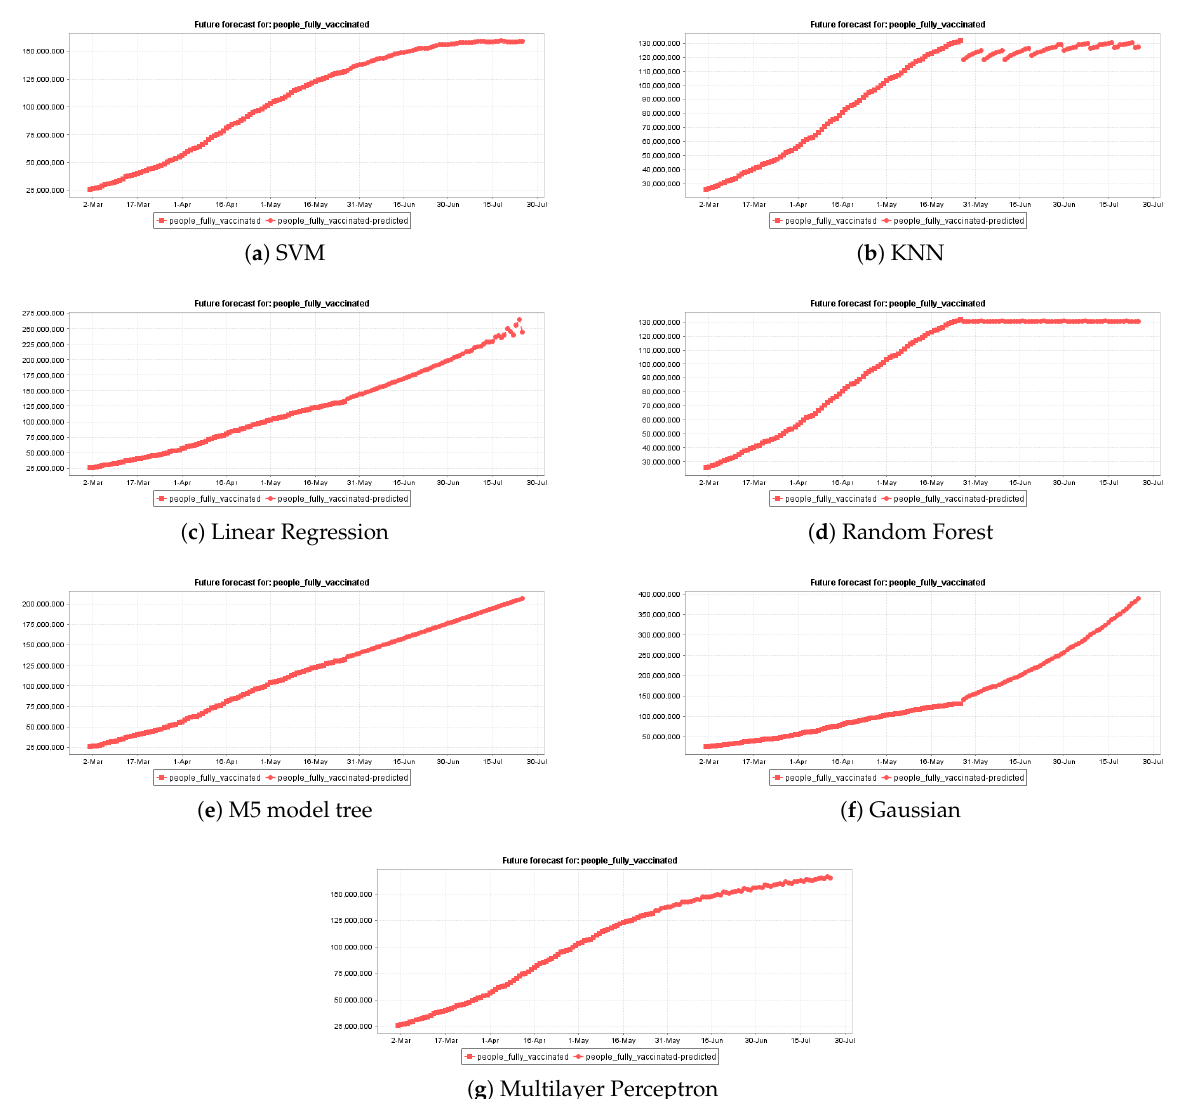
Figure 14. COVID-19 vaccination prediction to forecast fully vaccinated population in the USA for different machine learning models with forecast time of 2